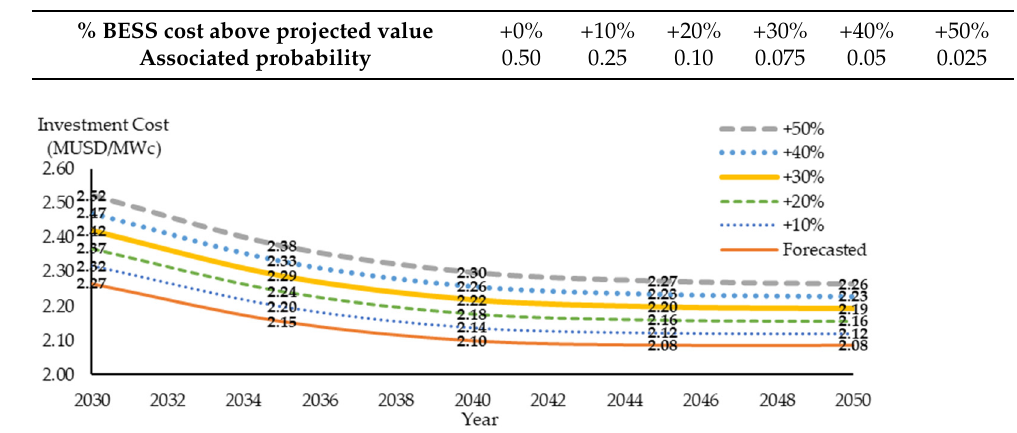
Figure 7. PVBESS profile of 1 MW contracted capacity unit.